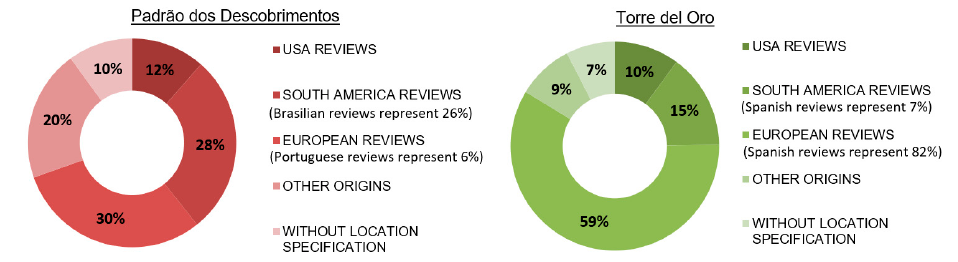
Figure 6. Number of TripAdvisor’s users in relation to their precedence in each case of study. Regarding Padrão dos Descobrimentos, 36.7% of the reviews were written in Por- tuguese, followed by 33.3% in English, and 30.1% in Spanish; 26% of the reviews were from Brazil and only 6% were from Portugal. Regarding Torre del Oro, 57.9% of reviews were written in Spanish, followed by 29.4% in English, and 12.7% in Portuguese. For this tries of South America only represented 7% of Latin America.